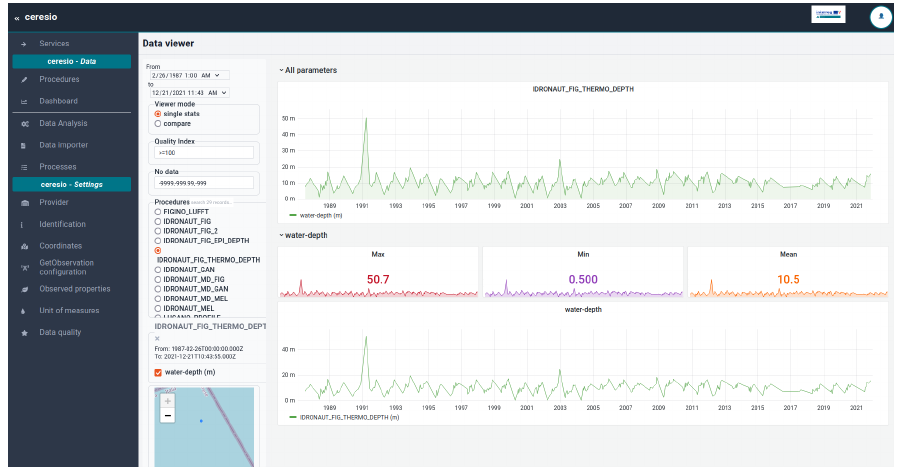
Figure 6. Thermocline depth calculated using the LakeAnalyer web plugin and the monthly data collected by the traditional campaigns, previously standardized and imported into istSOS.